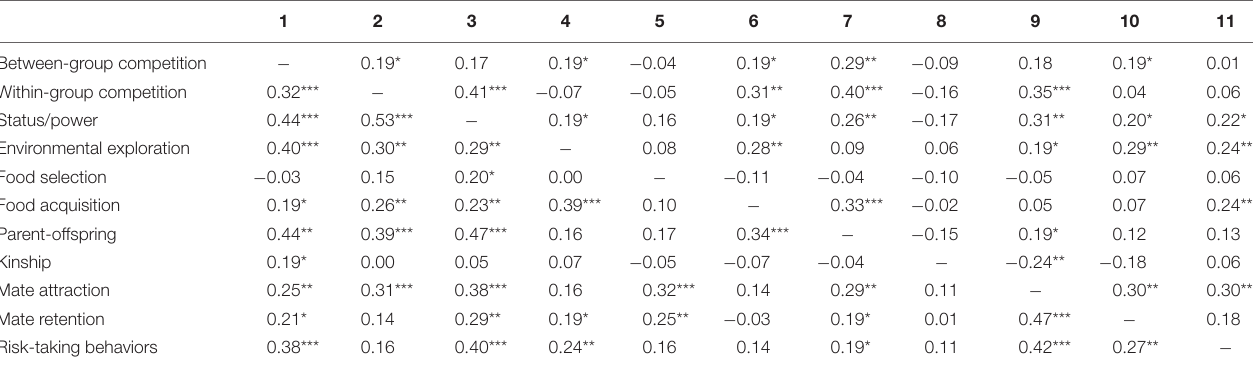
TABLE 6 | Zero-order correlations between risk propensity in the evolutionary-specific domains and risk-taking behaviors by